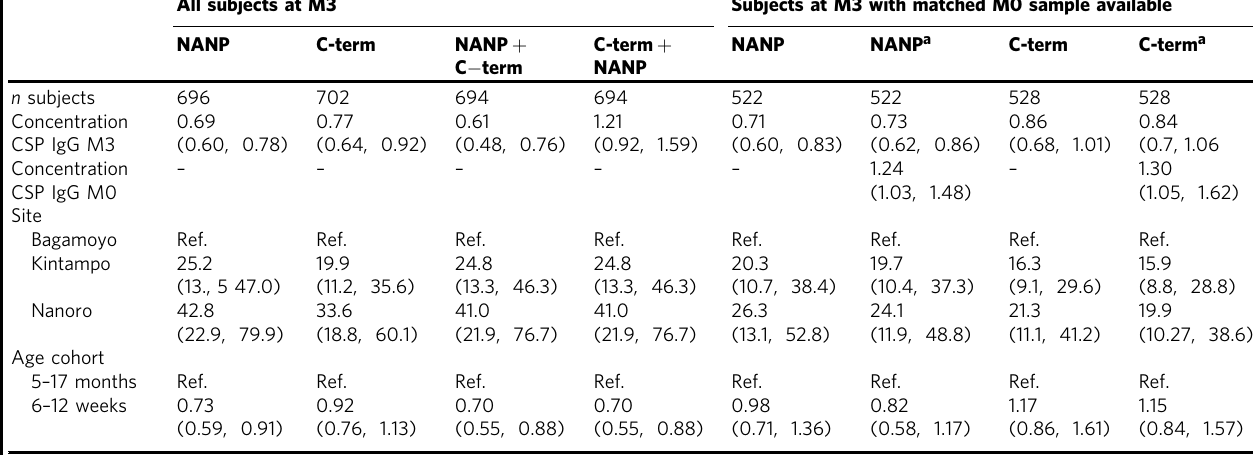
Table 2 IgG antibody concentrations to CSP in relation to risk of clinical malaria All subjects at M3 Subjects at M3 with matched M0 sample